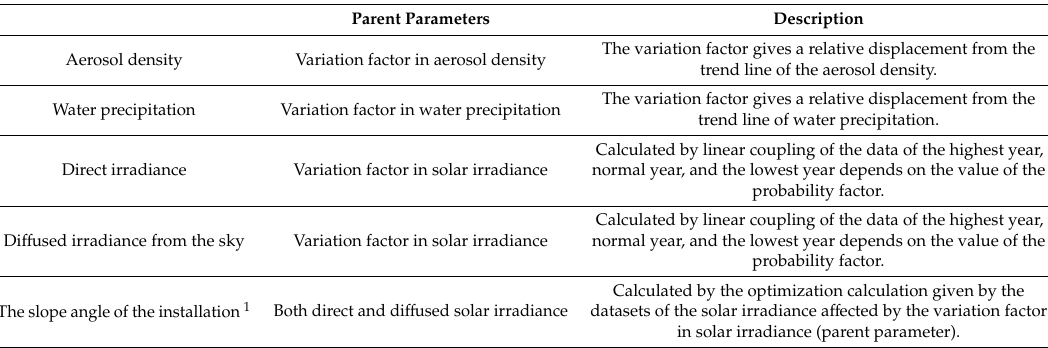
List of the probability parameters for modeling variation of annual performance (dependent